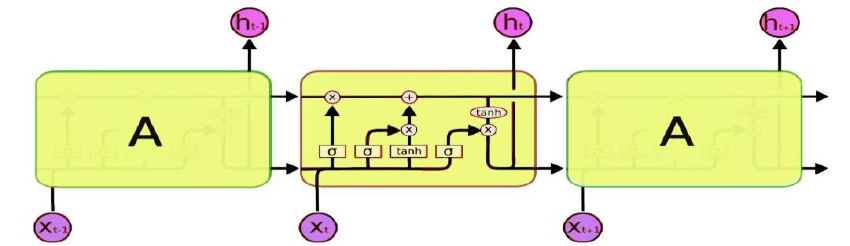
Figure 5. Long short-term memory (LSTM) architecture. Image source [96].